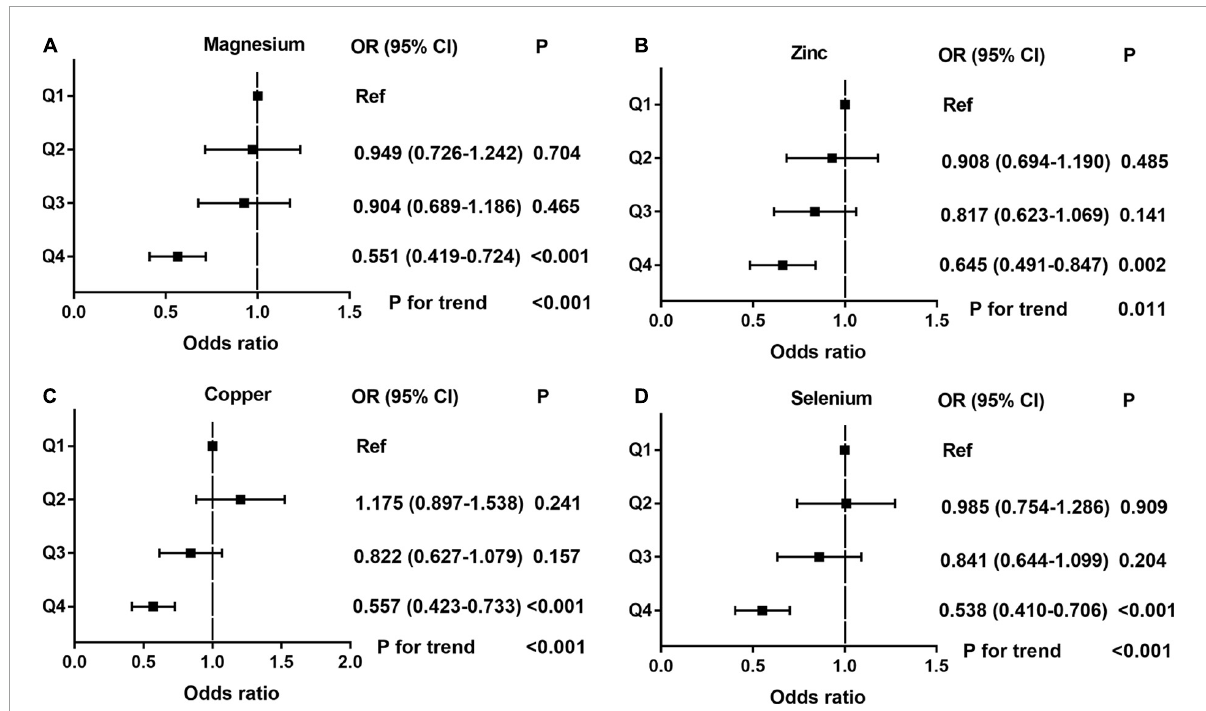
FIGURE6 The adjusted odds ratios (95% CI) of dietary metal intake and erectile dysfunction after propensity score matching. (A) Magnesium; (B) Zinc; (C) Copper; and (D) Selenium.